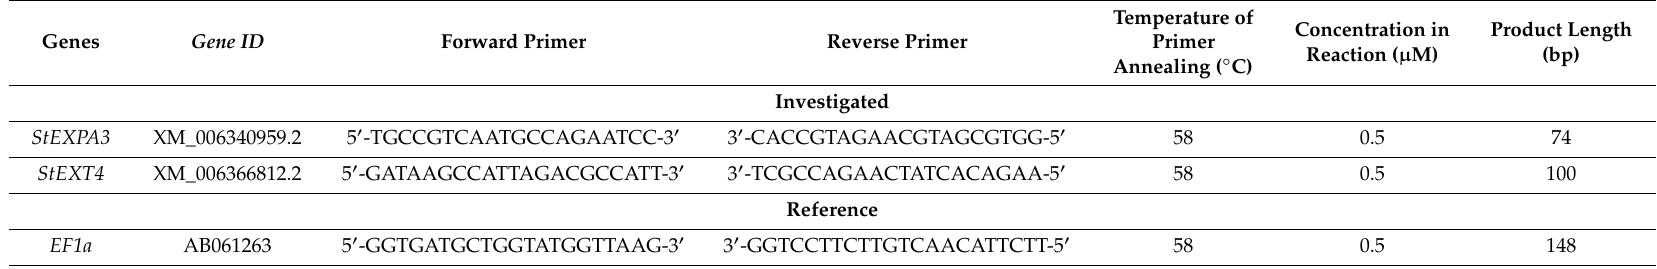
Table 1. Accessions of genes, sequences of primers, annealing temperatures, concentrations, and product lengths for the real-time qPCR.